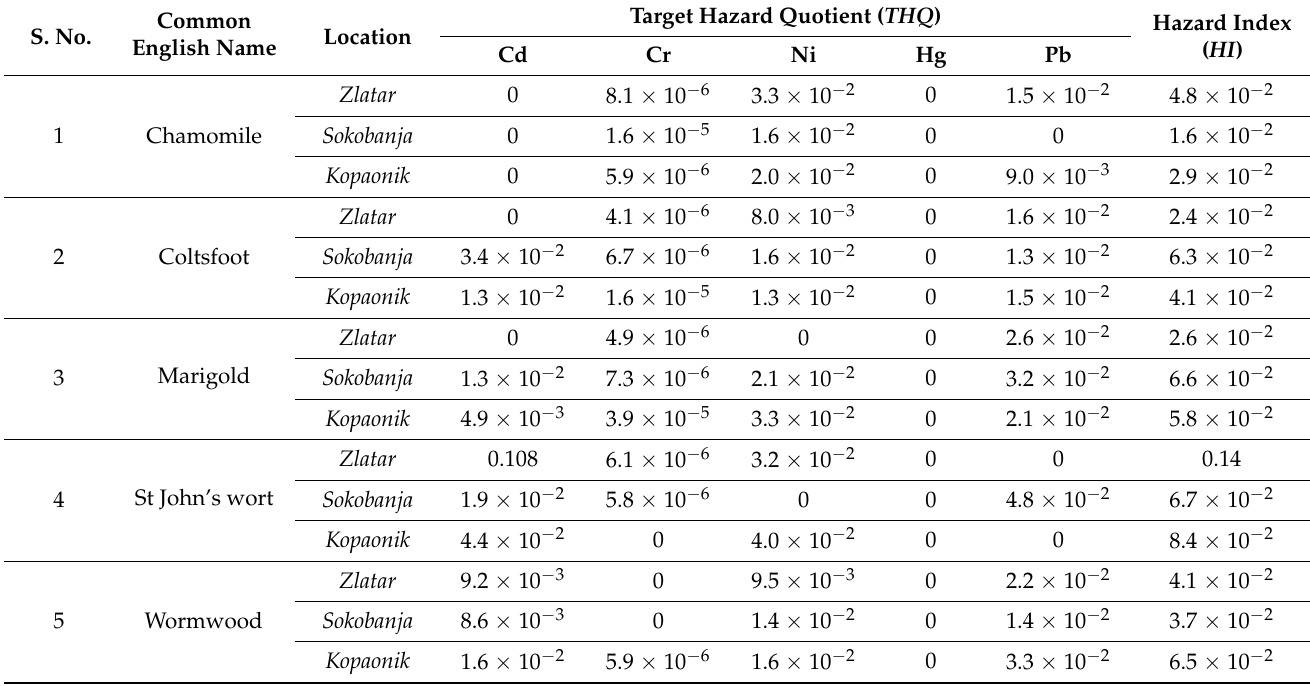
Table 7. Target hazard quotient ( THQ ) and hazard index ( HI